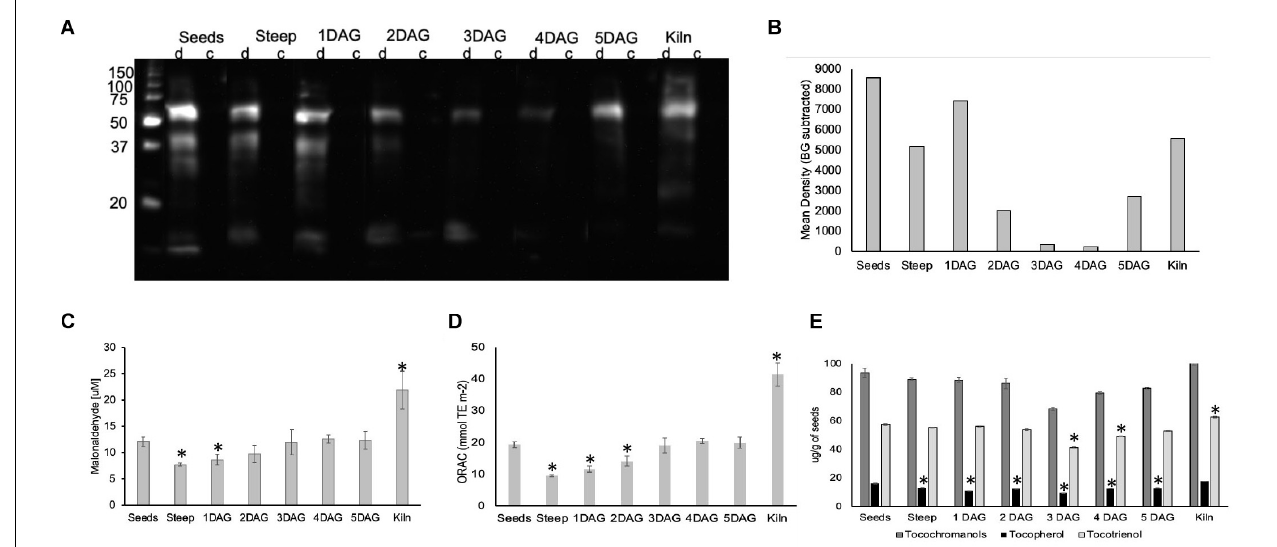
FIGURE 8 | Impact of ROS generated during barley malting on various biomolecules. (A) . An image of the western blot of the anti-DNP immunoassay for detecting oxidatively modified proteins of barley seeds during malting. (B) Membrane was scanned, and the mean background was calculated from the control (c) lane for each sample. The background subtracted signal intensity for each derivitazed (d) sample was used for plotting the graph. Representative results are shown. (C) Changes in lipid peroxidation during barley malting stages. ∗ Represent significantly different MDA levels in the sample when compared to their levels in the dry seeds ( p < 0.05). Error bars represent standard error ( n = 5). (D) Changes in the total antioxidant capacity during various stages of barley malting. Error bar represents the standard error ( n = 5). ∗ Represents statistically significant changes in the antioxidant capacity when compared to dry seeds ( p < 0.05). (E) Changes